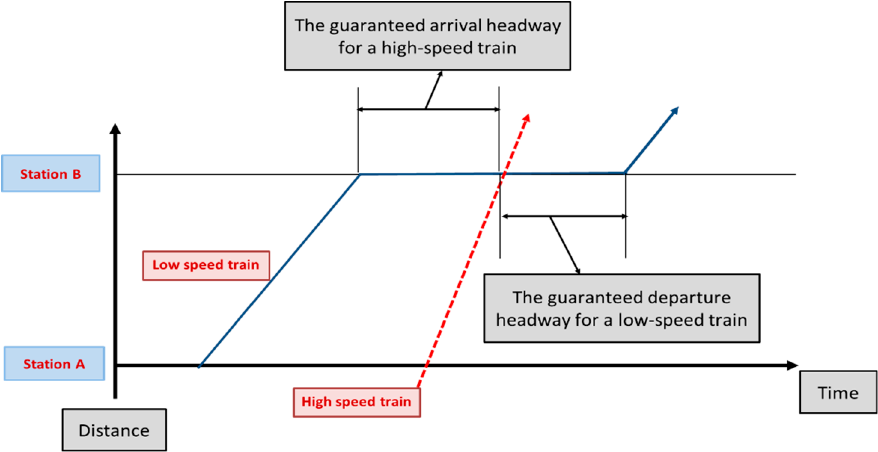
Figure 3. Illustration of guaranteed headway for high and low-speed trains.